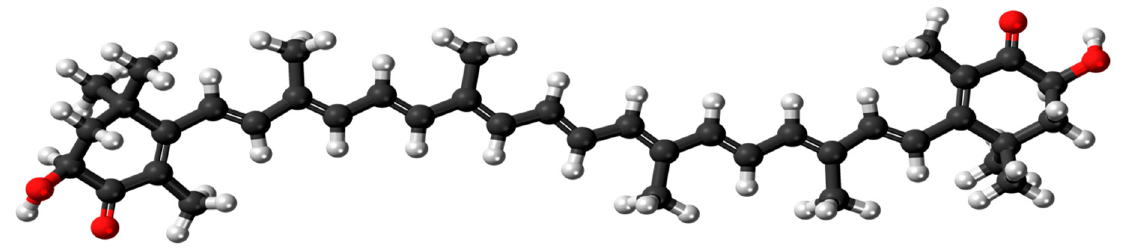
Figure 1. Structure of all- trans astaxanthin (C 40 H 52 0 4 : carbon—black, hydrogen—white, oxygen—red). By Jynto: this image was created with Discovery Studio Visualizer, CC0, https://commons.wikimedia.org/w/index.php?curid=16311511. (accessed on 9 February